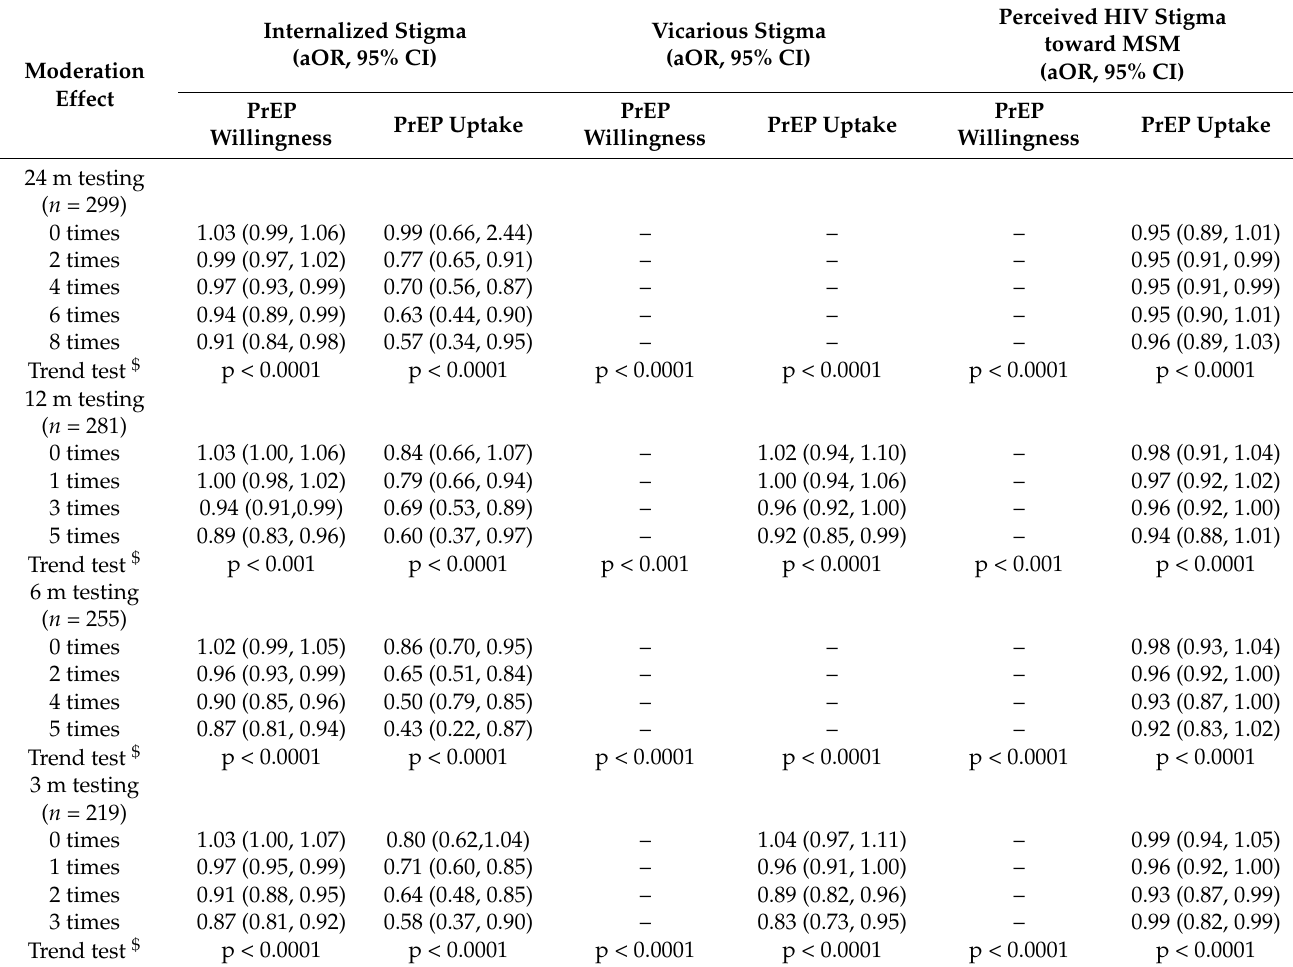
Table 4. Moderation effect of HIV testing at different time points between the association between PrEP stigma and the PrEP cascade ( n = 318)